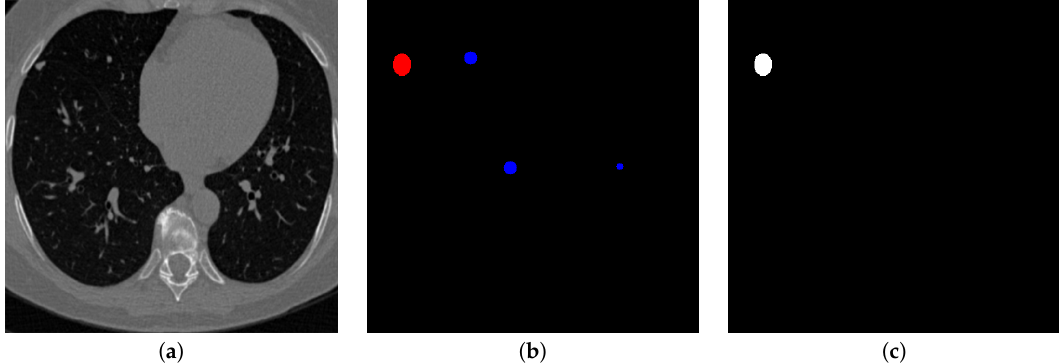
Figure 9. An example of detecting nodule candidates from the chest CT image. ( a ) is the input chest CT image, ( b ) is the nodule candidates detected by the proposed nodule candidate detection sub-network, ( c ) is the ground truth nodule